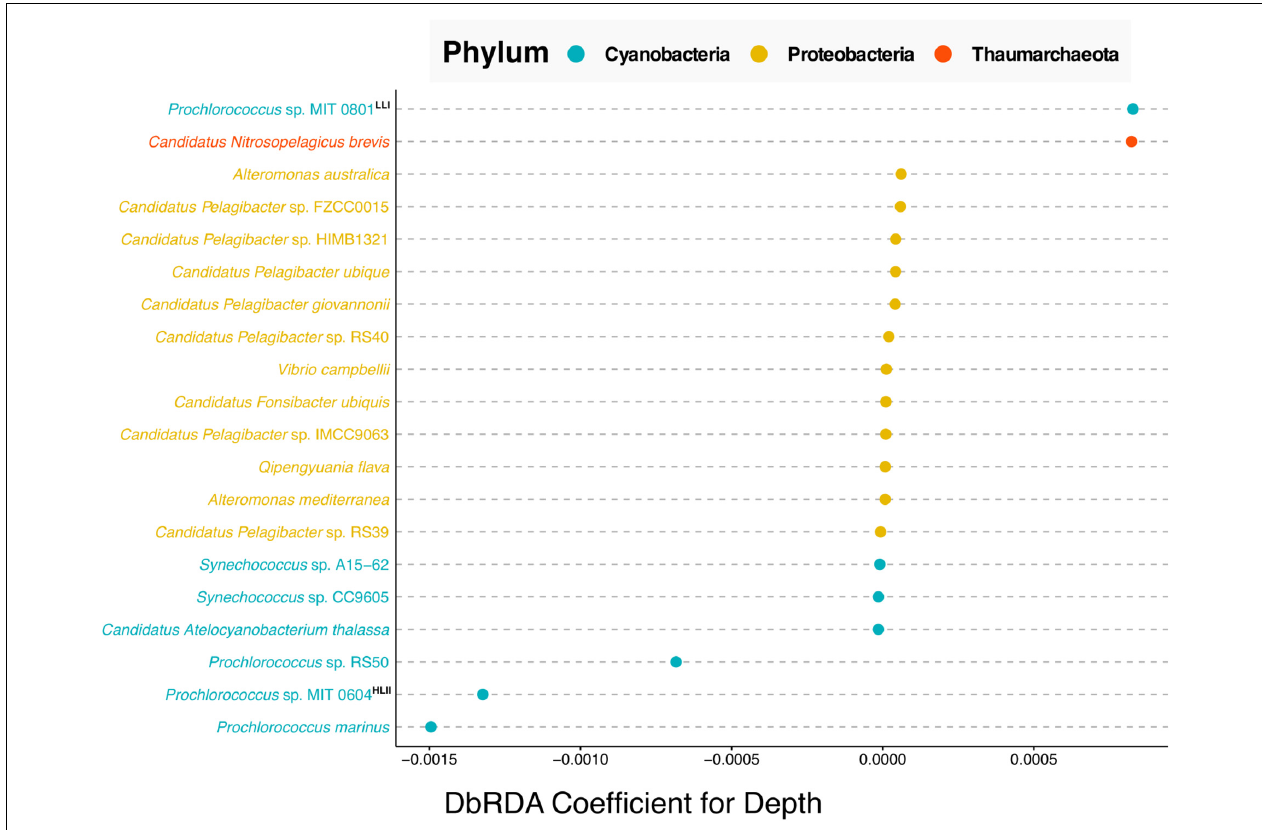
FIGURE 4 | Cleveland’s dot plot showing the top 20 coefficients ordered by absolute value, derived from a distance-based redundancy analysis (dbRDA) of the relative abundance of bacterial and archaeal species against depth. Species are colored by taxonomic phylum with Cyanobacteria in blue, Proteobacteria in yellow and Thaumarchaeota in orange. LLI and HLII indicate “high light adapted” and “low light adapted,” respectively based on the analysis of Biller et al. (2014). The depth of samples used in this analysis ranged between 25 and 125 m.